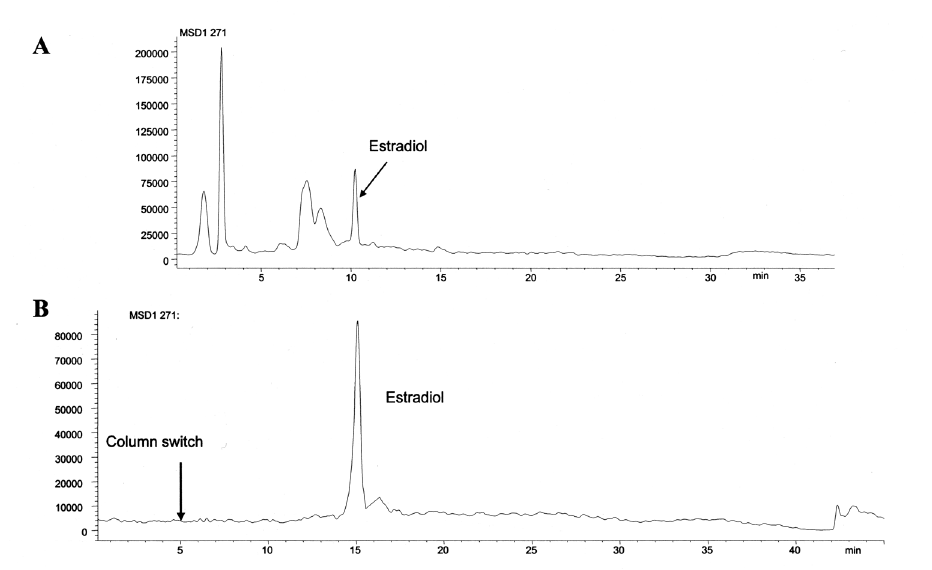
FIGURE 4 . Comparison of LC–MS extracted chromatograms for estradiol (m/z 271) in spiked sediment: (A) ASE-SPE-LC-MS; (B) ASE-RAM (C4)